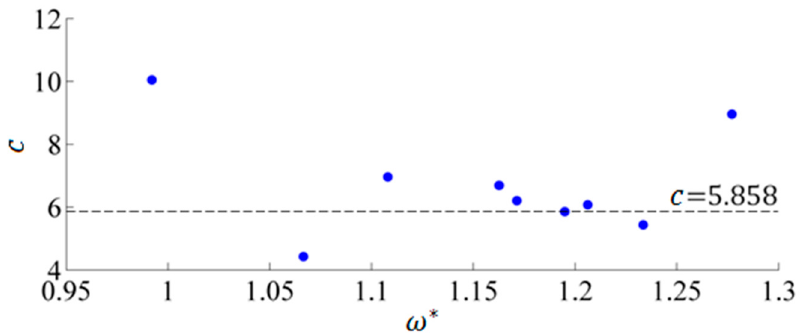
Figure 11. The damping coe ffi cient c versus the incident wave frequency ω ∗ in the present numerical study ( B ∗ g = 0.1 )